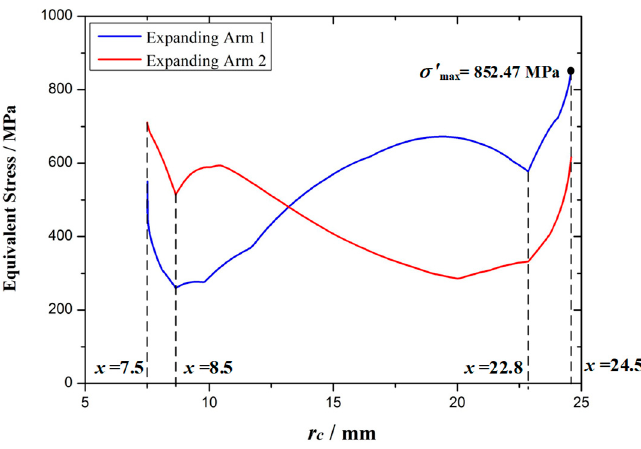
Figure 14. Optimization process of the expanding arm.